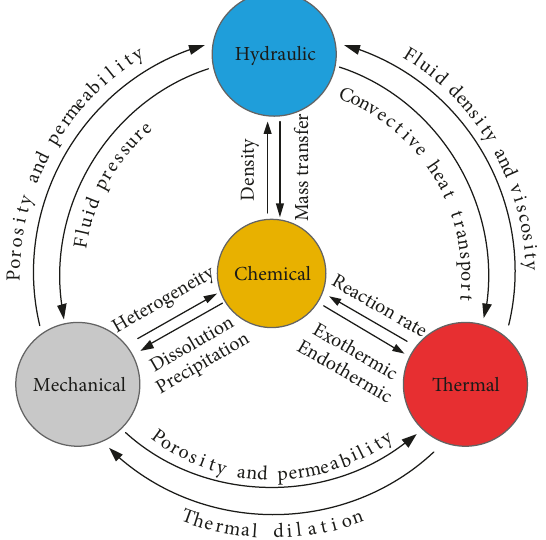
Figure 3: Cross-couplings between THMC processes.